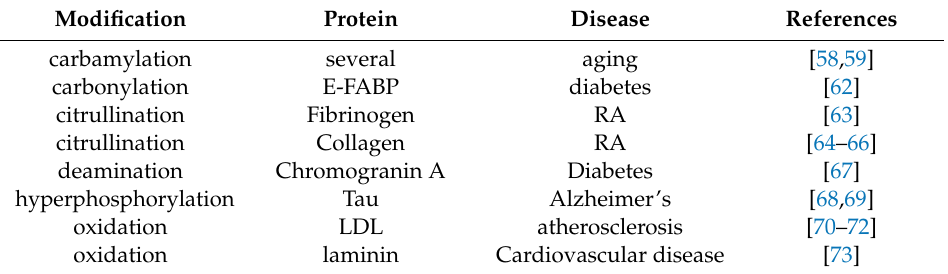
Table 1. Protein post-translational modifications (PTMs) linked to the cause of